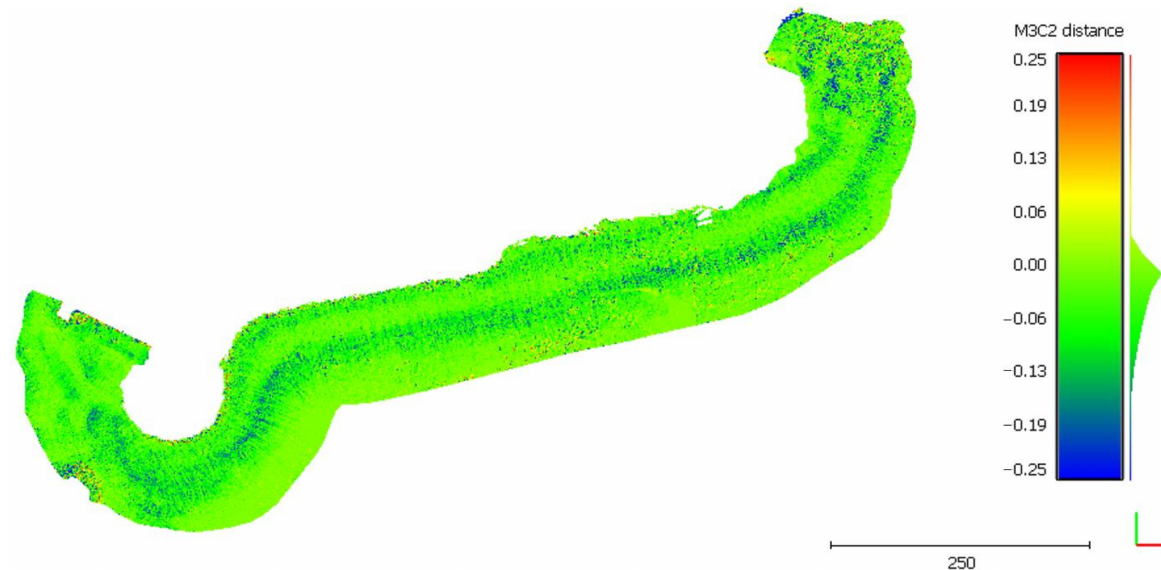
Figure 8. Comparison between DSM 1 (reference) and DSM 2 (compared) on the sea bottom, with distance values limited within the interval ( − 0.25; 0.25) m.